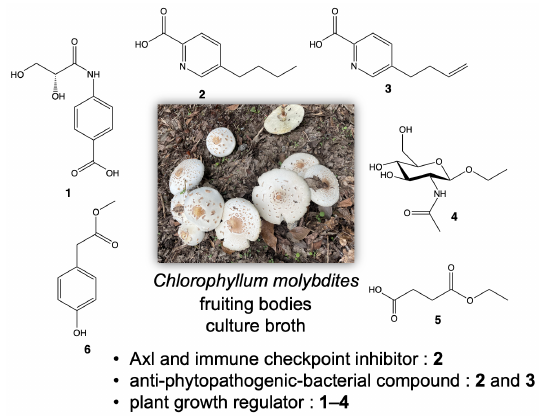
Figure 6. Summary of this